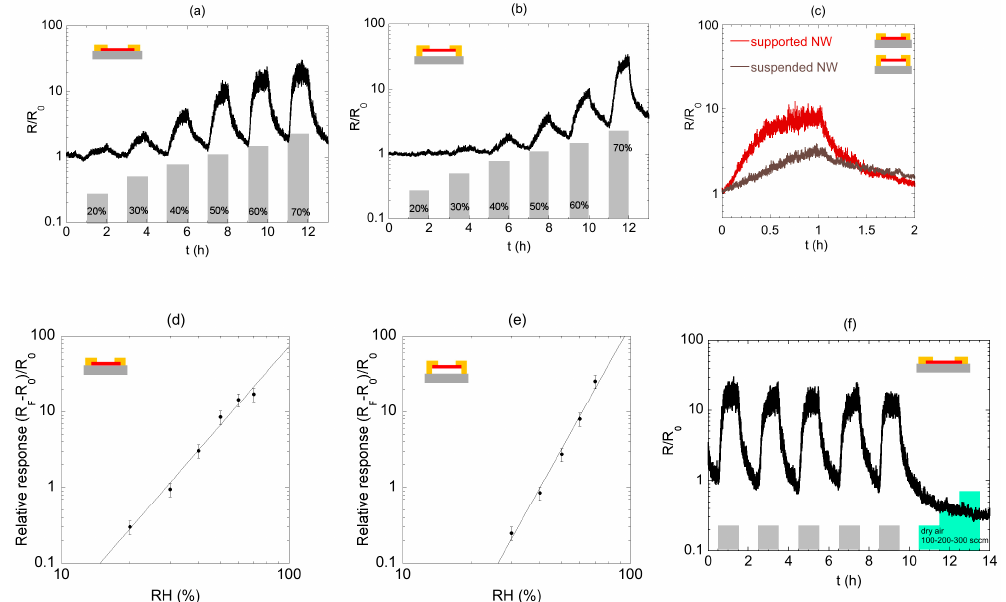
Figure 4. Dynamic variation of the normalized nanowire resistance towards changes in relative humidity (r.h.) from 20% to 70% for ( a ) supported nanowire and ( b ) suspended nanowire. The cycle time (humid air/dry air) is 2 h. ( c ) Normalized resistance for the two devices, for 50% r.h. ( d ) Calibration curve for supported device; extracted fit parameters (power law) are A = 9.06 × 10 ‒ 6 and B = 3.45. ( e ) Calibration curve for the suspended device; parameters of the power law in the fit are A = 3.18 × 10 ‒ 5 ; B = 3.15. ( f ) Repeatability of the resistance change when the substrate-bound NW device experience a change between dry air and 50% r.h. (gray area). Light-blue steps refer to change in the air flowing through the test chamber from 100 to 300 sccm.